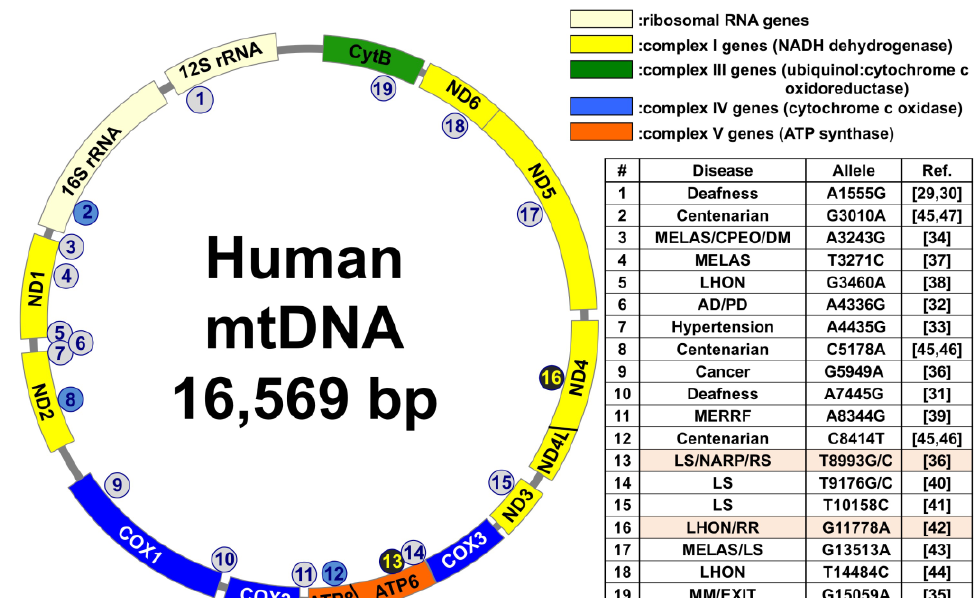
Figure 1. Mitochondrial DNA ( mtDNA) mutations that cause various diseases, as well as mtDNA mutations that affect longevity or radioresistance. Centenarian: a person over 100 years old; MELAS: mitochondrial myopathy, encephalopathy, lactic acidosis, and stroke-like episodes; CPEO: chronic progressive external ophthalmoplegia; DM: diabetes mellitus; LHON: Leber’s hereditary optic neuropathy; AD/PD: Alzheimer’s and Parkinson’s diseases; MERRF: myoclonic epilepsy and ragged red fibers; LS: Leigh syndrome; NARP: neuropathy, ataxia, and retinitis pigmentosa; RS: radiosensitive; RR: radioresistance; MM: mitochondrial myopathies; EXIT: exercise intolerance.